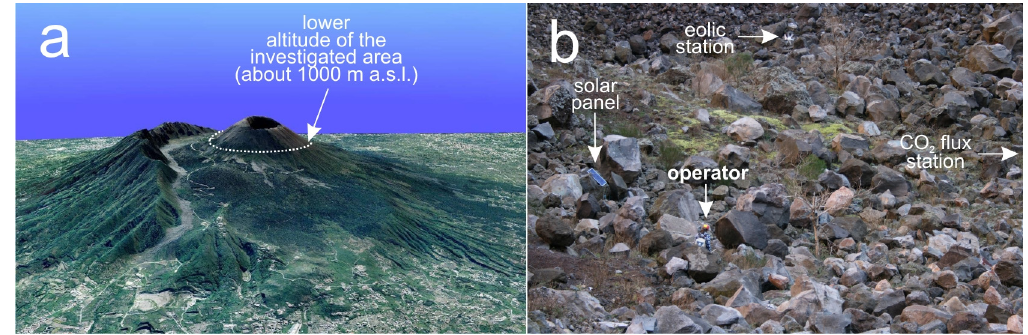
Figure 1 . a) Perspective view (from NNE) of Vesuvio cone and Somma caldera (image elaborated by the Laboratorio di Geomatica e Car- tografia of Istituto Nazionale di Geofisica e Vulcanologia, Osservatorio Vesuviano). Investigated area covers the summit cone, above the con- tour line of ~1000 m; b) bottom of Vesuvio crater, densely mantled by fallen lava blocks. Some devices forming the power system of the flux station (eolic power plant and solar panel) are also visible. Station is out of the automatic CO 2